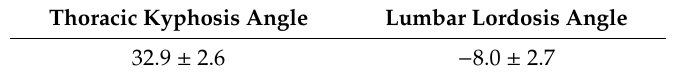
Table 5. Thoracic kyphosis angle and lumbar lordosis